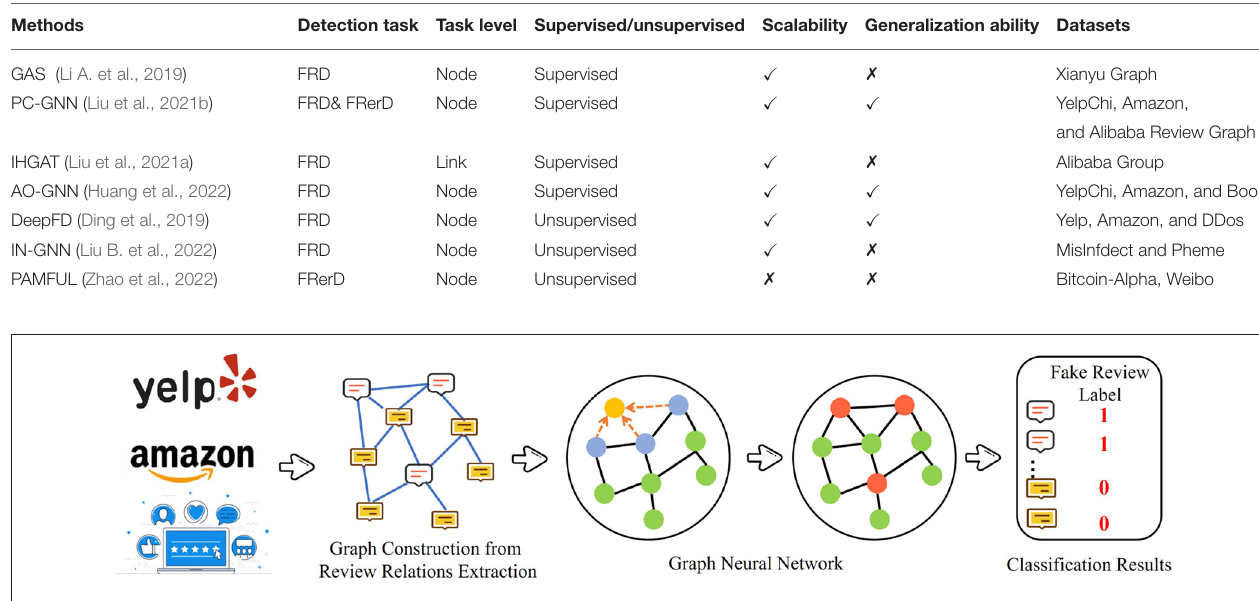
TABLE 3 | Comparative review of graph learning methods for fake review detection. Methods